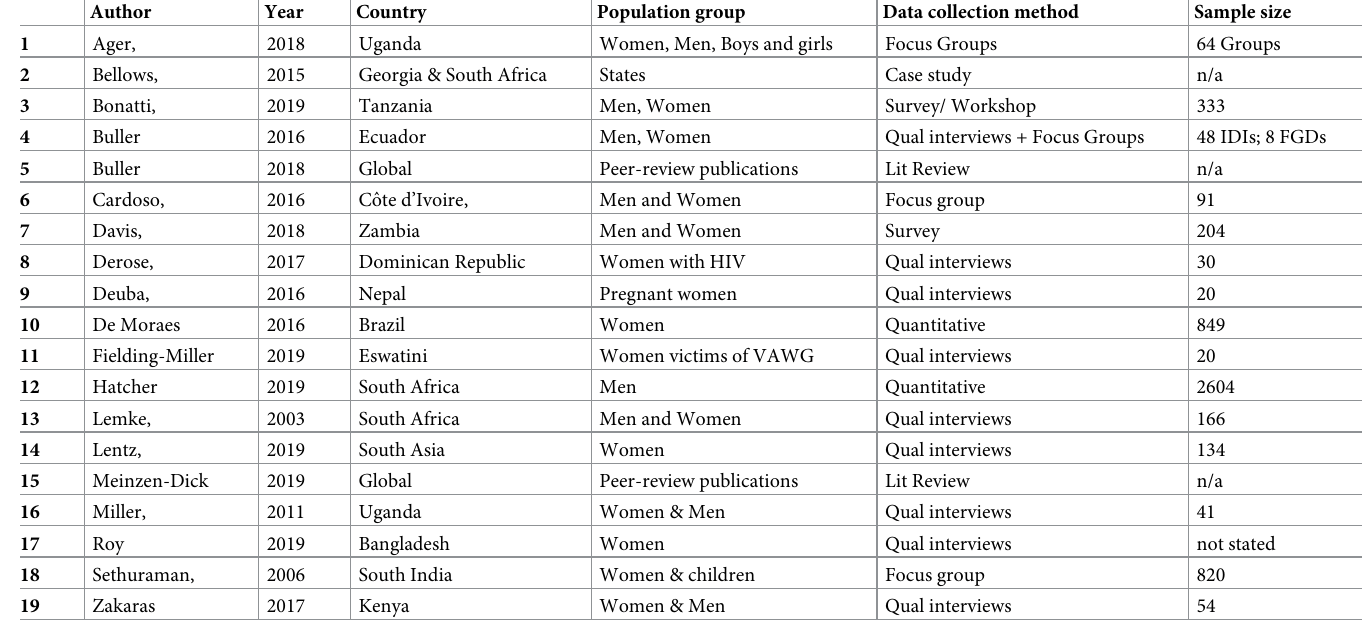
Table 2. Qualitative and mixed-methods studies included in systematic